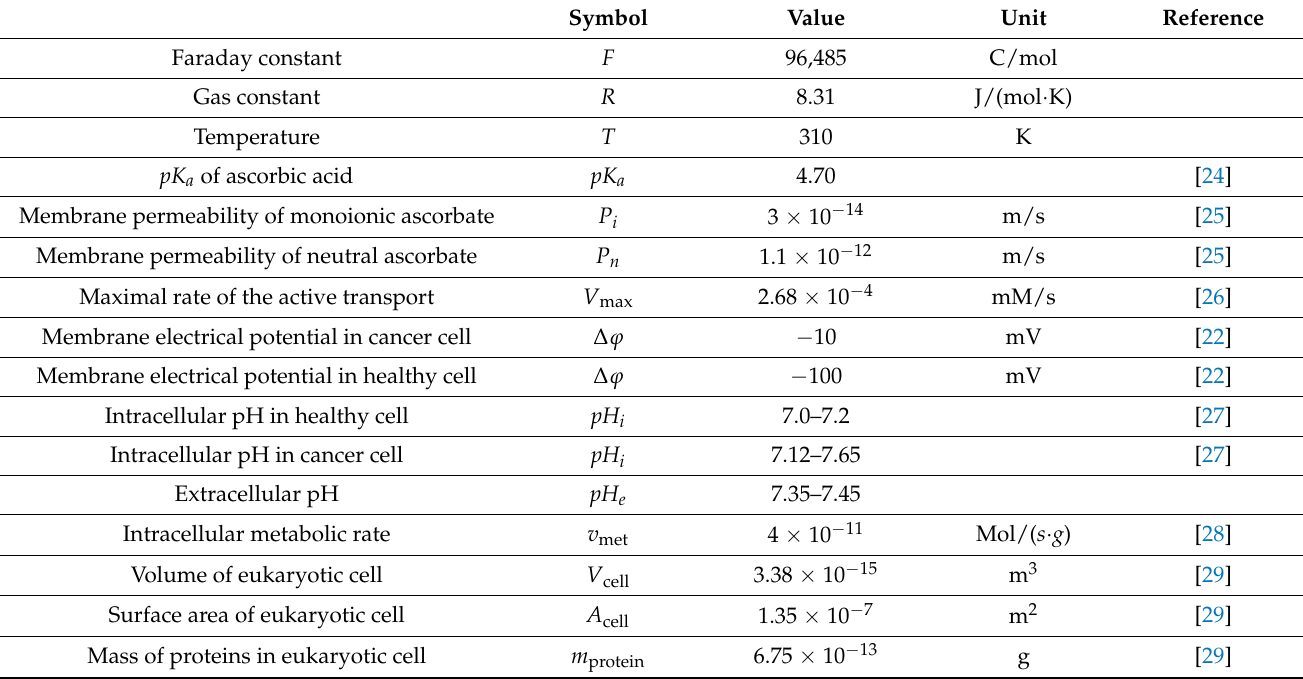
Table 1. The numerical values of relevant parameters of healthy and cancer cells used for the calculations [22,24–29].